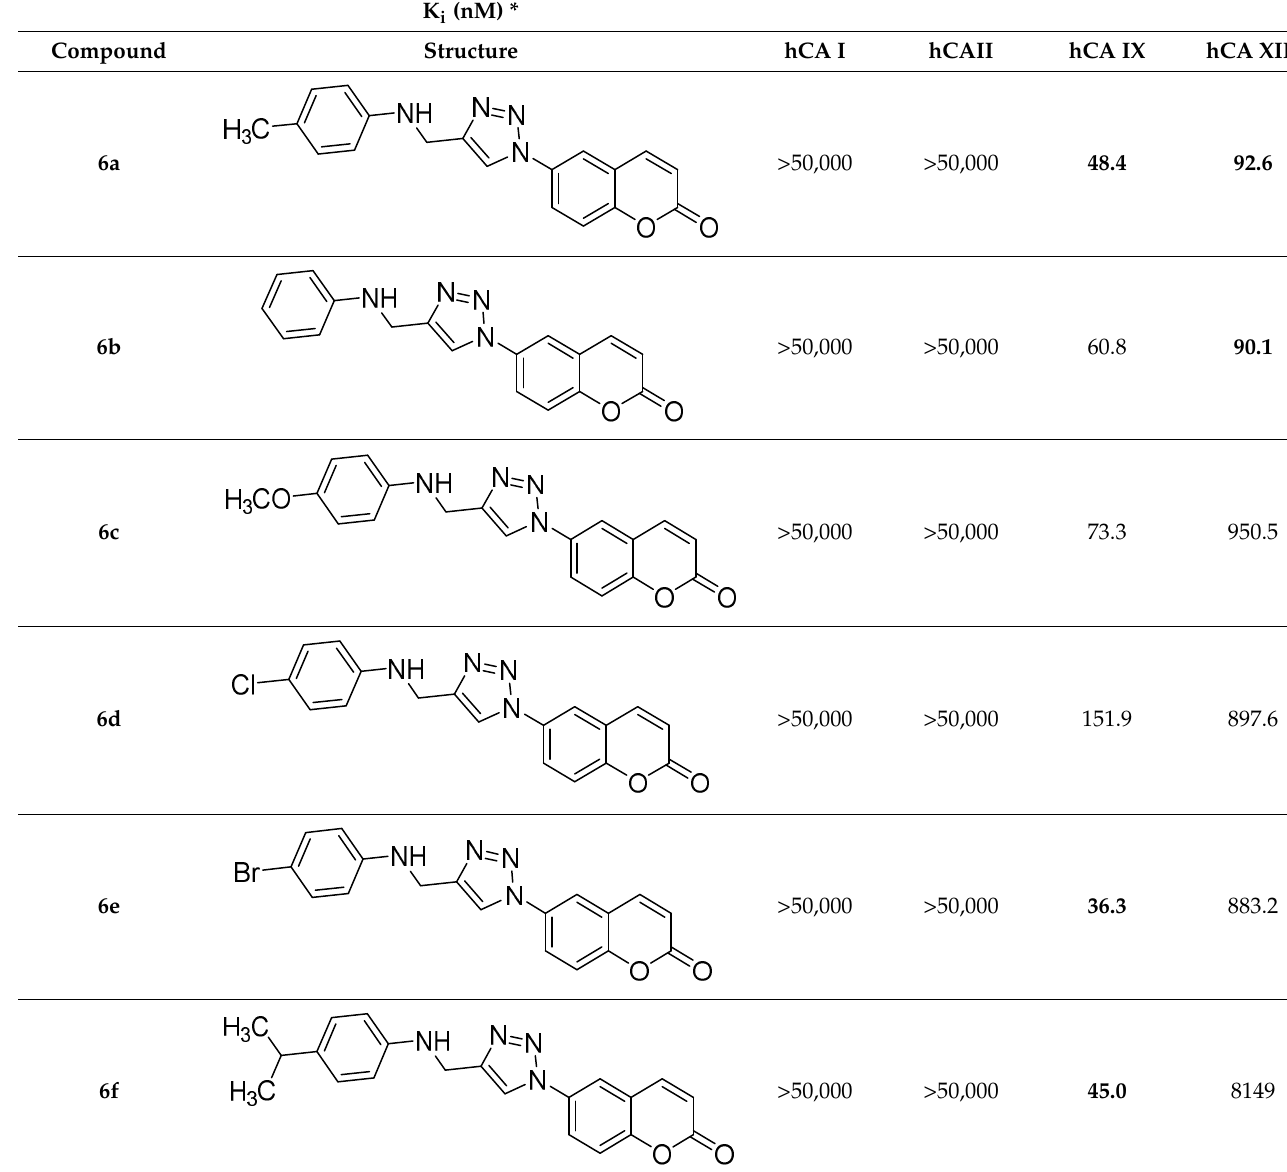
Table 1. Inhibition of hCA isoforms I, II, IX and XIII with compounds 6a – t and acetazolamide (AAZ) as standard inhibitor.